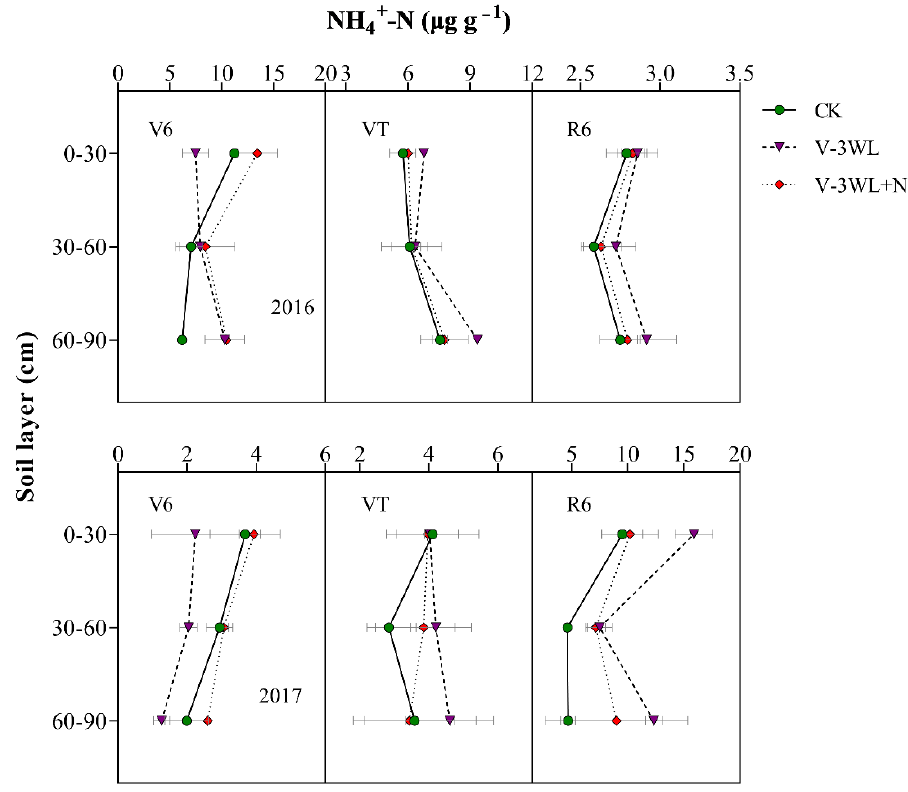
Figure 4. Effects of applying nitrapyrin on the soil NH 4+ -N content under a waterlogged field. 238 V-3WL, waterlogging treatment with urea application only; V-3WL+N, waterlogging treatment 239 with urea and nitrapyrin application; CK, not waterlogged, but applied only urea. The error bars 240 represent 95% confidence intervals.